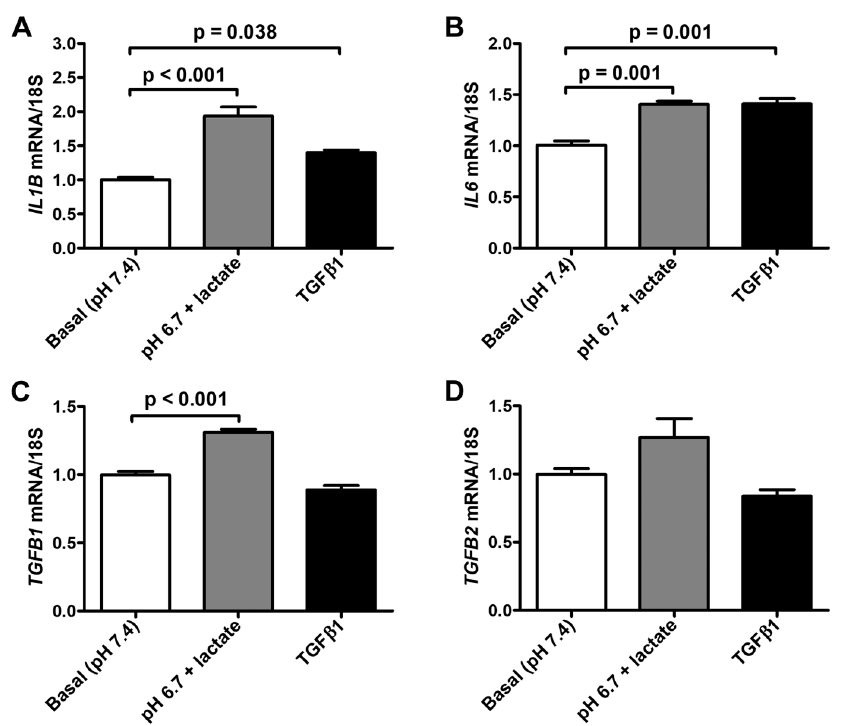
Figure 6 . Quantitative real-time PCR analysis for the expression of the pro-in fl ammatory IL1B ( A ) and IL6 ( B ) genes and the pro-fibrotic TGFB1 ( C ) and TGFB2 ( D ) genes in adipocyte-committed adipose-derived stem cells grown for 3 days under basal (pH 7.4) conditions, lactic acidosis (pH 6.7 + lactate) or in the presence of 10 ng/mL TGF β 1. The basal level of each gene expression was set to 1, and the other results are normalized to this value. 18S ribosomal RNA was used as the reference gene. Bars represent the mean ± SEM of three independent experiments ( n = 3 replicates each) from the three cell lines. Values of p were determined by Tukey(cid:31)s test.